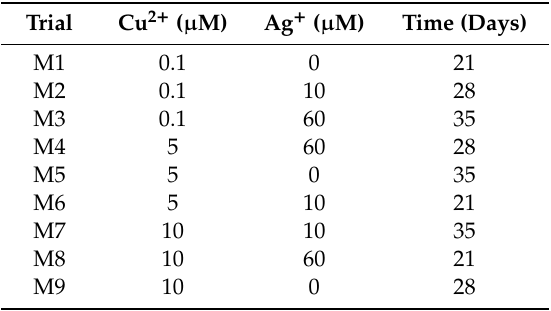
Table 4. Concentrations of ions and number of days applied in trials (M1–M9).